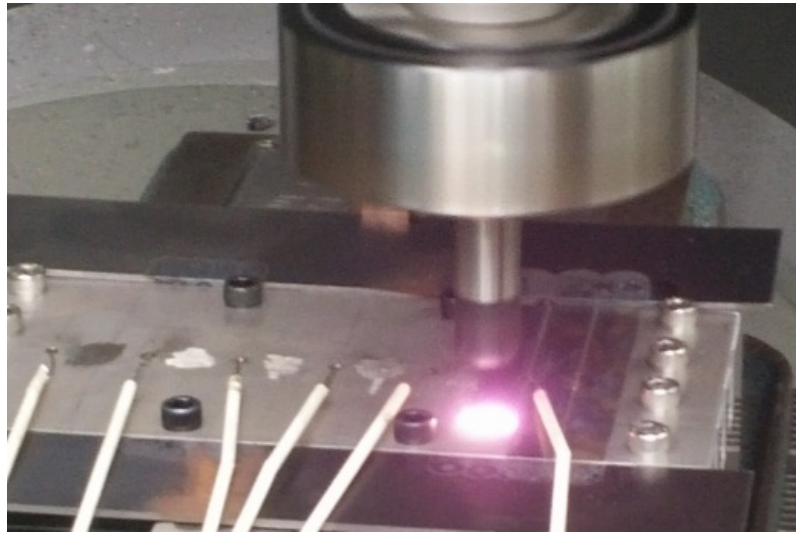
Figure 4. Thermocouple arrangement and laser quench processing.